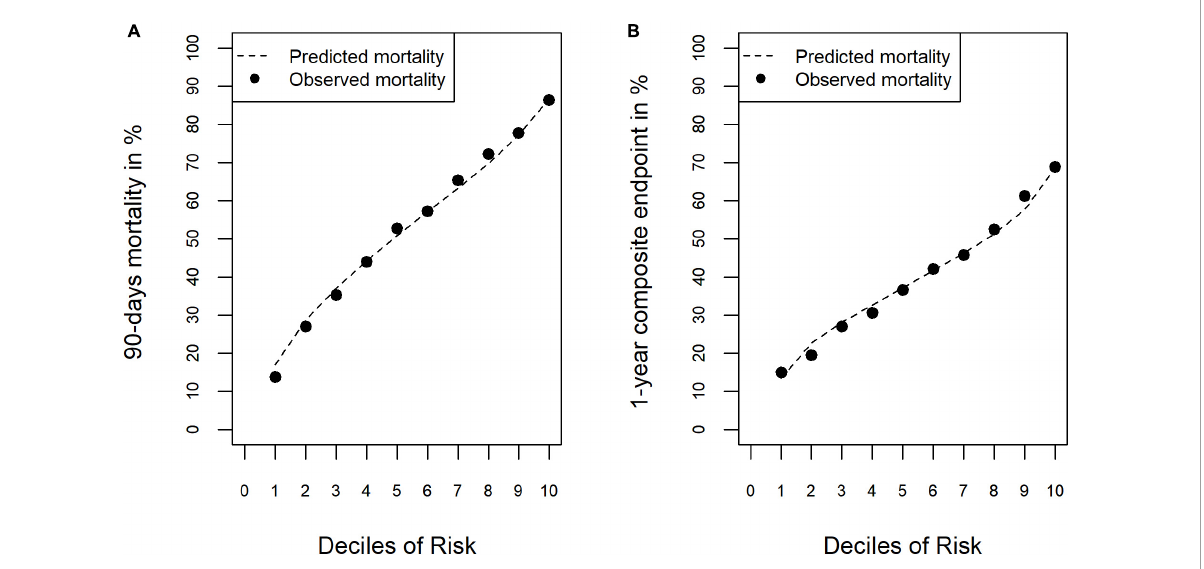
FIGURE1 Calibration of the risk-adjustment models. (A) 90-day mortality. (B) 1-year composite endpoint (1-year mortality or increased dependency on chronic